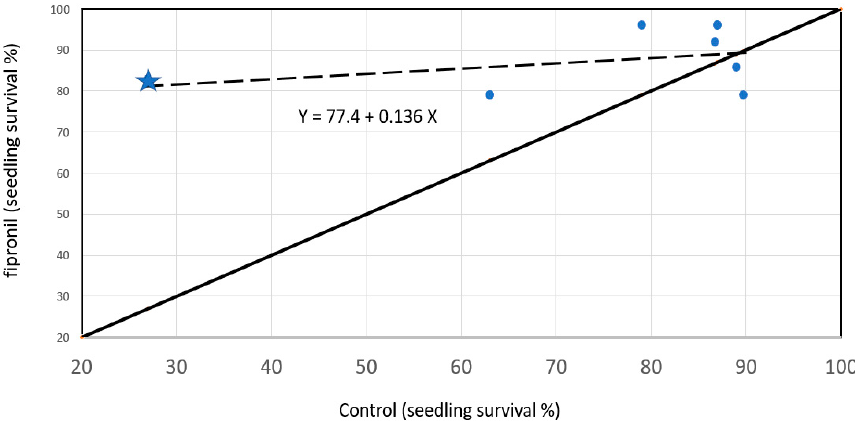
Figure 21. A dilution of fipronil was applied to the root zone within one week of planting bareroot loblolly pine seedlings (March 2008) at seven sites in Virginia [153]. The insecticide increased survival on three sites ( α = 0.10) and reduced foliar damage to seedlings at six sites. Harvest of pines prior to planting was completed before July 2007 except for one site harvested in October 2007 (blue star). Points above the solid line represent sites where fipronil increased survival. p > |t| = 0.0007 for intercept and 0.42 for slope; R 2 = 0.13.